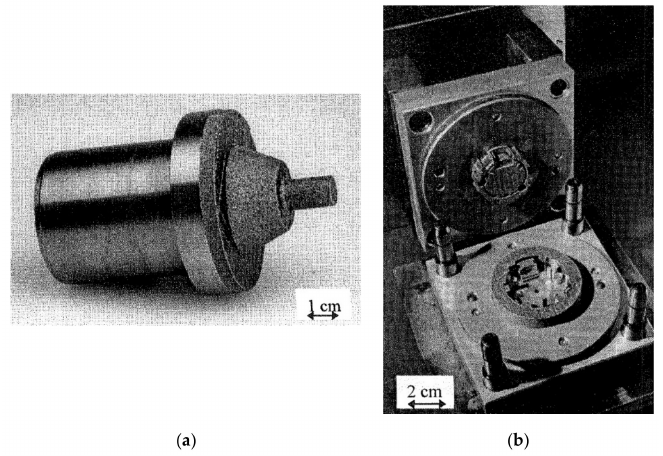
Figure 2. Tools made by the then (1999) newly developed selective laser melting (SLM): ( a ) slider for a die casting tool made in 1.2343 and ( b ) injection molding tool made in 316L